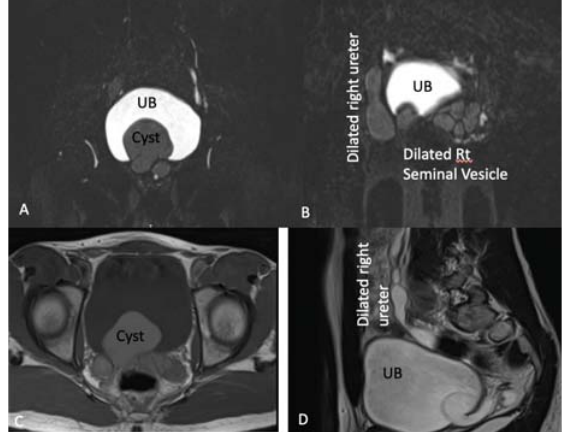
Figure 4. MR urography images demonstrating dilated right seminal vesicle with cystically dilated portion protruding into the bladder and the dilated right ureter (A,B); T1 weighted coronal image showing the dilated right seminal vesicle showing iso to mild high signal intensity content (C); T2 weighted sagittal images showing the dilated right ureter draining into the cystically dilated right seminal vesicle